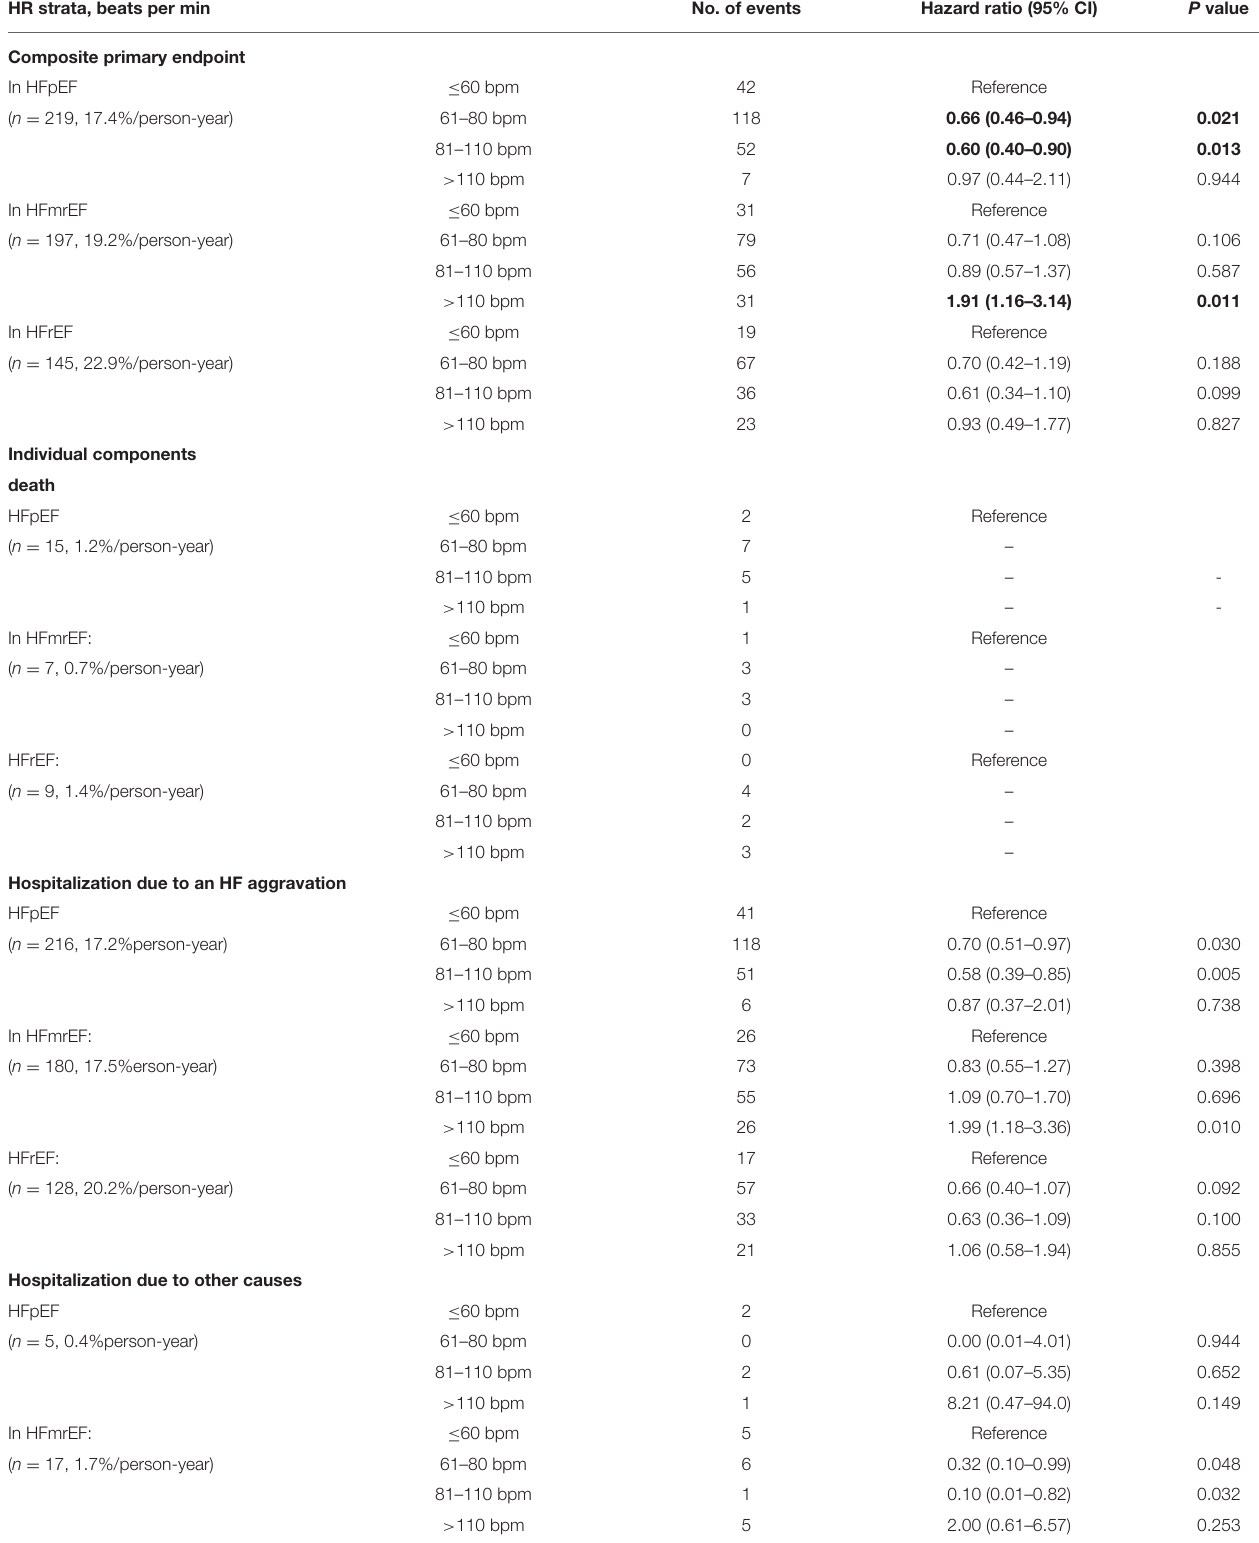
TABLE 2 | Cox regression analyses of the effect of the heart rate on the primary endpoint. HR strata, beats per min No. of events Hazard ratio (95%